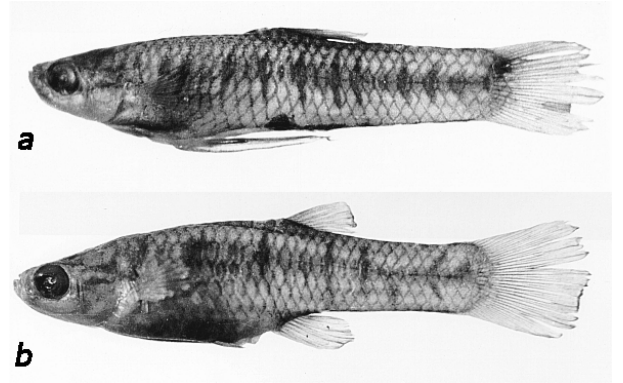
Fig. 7. Cnesterodon hypselurus : (a) holotype, male, MCP 22743, rio Cilada, Jaguariaíva, Paraná, Brazil. 23.9 mm SL; (b) paratype, female, MCP 22744, 28.0 mm SL, collected with the holotype.